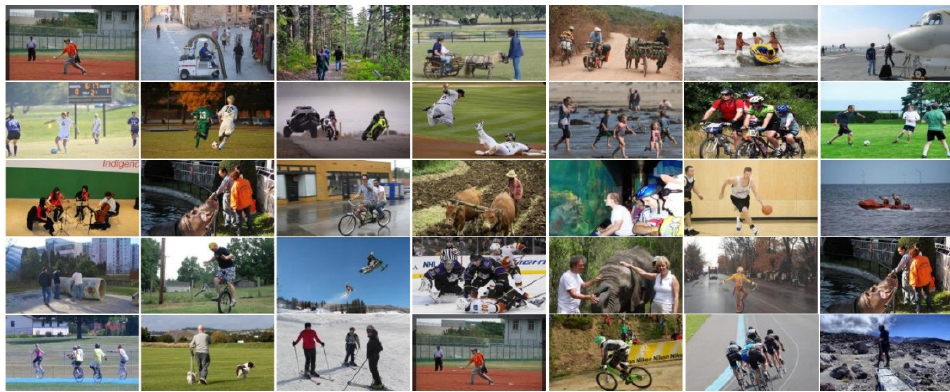
Figure 8. Example of experimental gaze images.